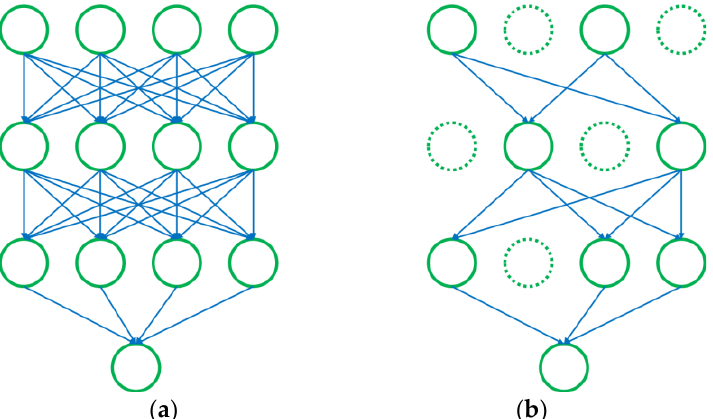
Figure 15. Schematic diagram of dropout. ( a ) Without dropout layer; ( b ) With dropout